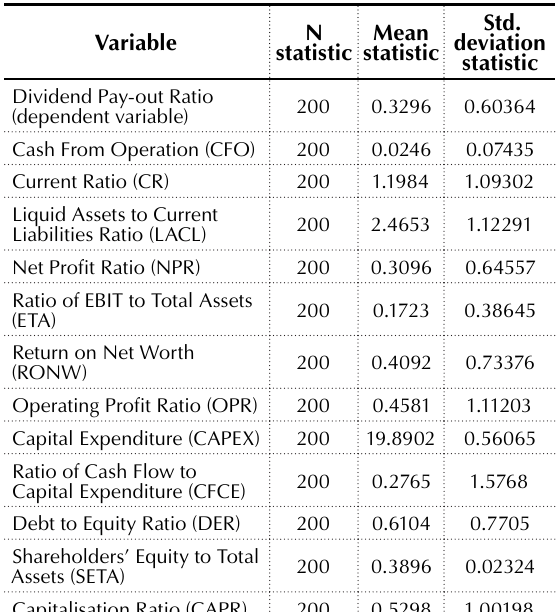
Table 2. Summary